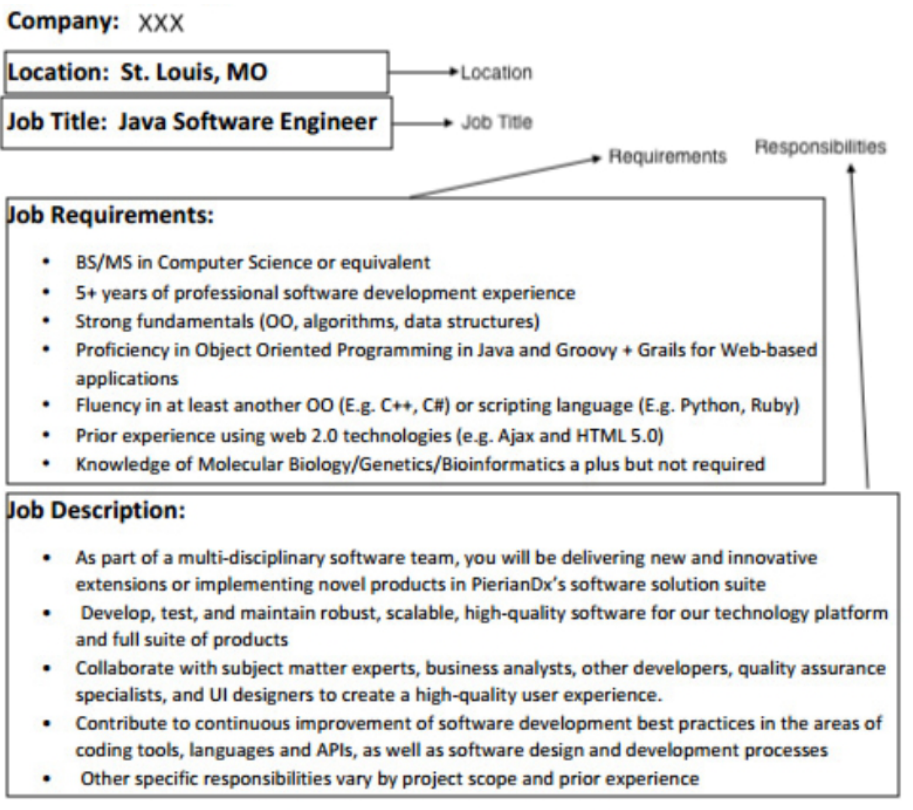
Figure 1. A sample Job description with marked